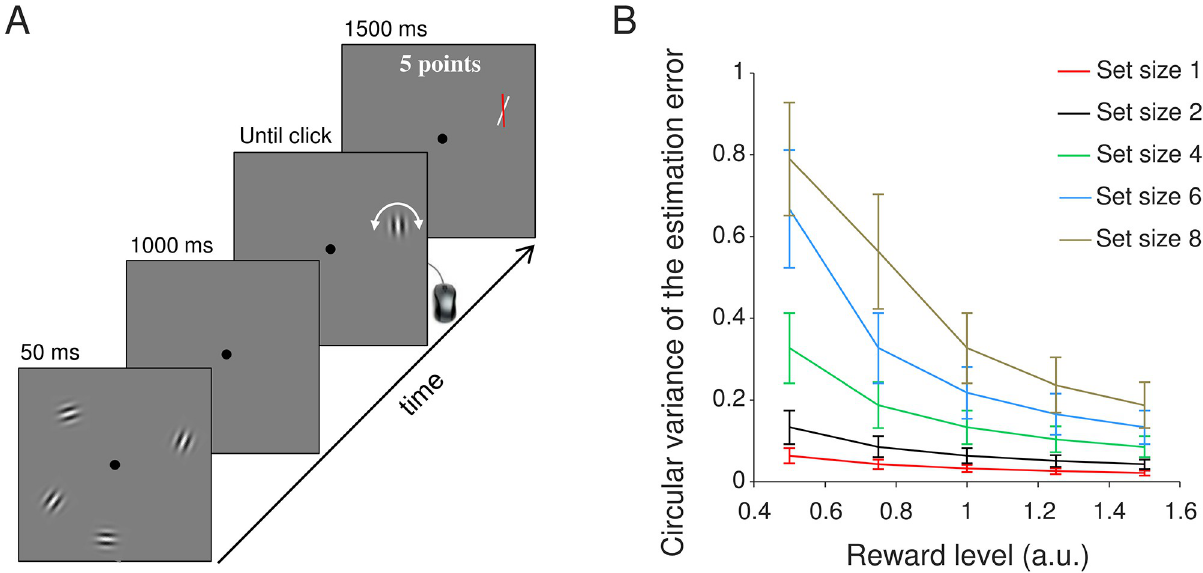
Fig 1. Experimental procedure. (A) Illustration of a single trial in Experiment 1 (not to scale). Subjects were briefly presented with 1, 2, 4, 6, or 8 Gabor patches, which they had to keep in memory during the delay period. Thereafter, a randomly oriented Gabor patch would appear at one of the previous stimulus locations. The task was to match the orientation of this stimulus with the remembered orientation of the stimulus that had appeared earlier at this location. After submitting their response, the subject was presented with feedback about the size of their response error. Subjects received points on each trial (larger error = fewer points), which after the experiment were converted into monetary reward. Different groups of subjects received different levels of reward. (B) Predictions of the resource-rational model about the effect of reward level ( x axis) on VWM error (y axis). The predictions were obtained by simulating responses of the model presented in Van den Berg & Ma (2018). Simulations were performed at five set sizes (separate lines) and 5 reward levels. Each of the simulations was performed six times, with each run using the maximum-likelihood parameters of one of the six subjects in experiment E4 Van den Berg & Ma (2018). Error bars represent ± 1 SEM across the six runs. A two-way Bayesian ANOVA on the simulation data show strong evidence for an effect of both set size (BF incl > 10 13 ) and reward level (BF incl > 10 8 ), as well as for an interaction effect (BF incl =